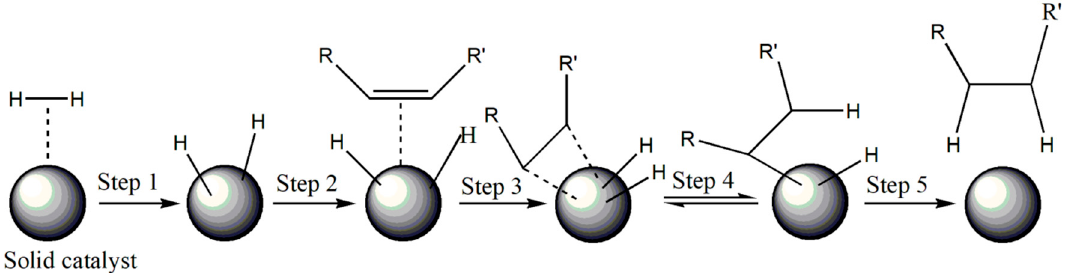
Figure 4. Heterogeneous hydrogenation mechanism according to Horiuti–Polanyi mechanism [33].